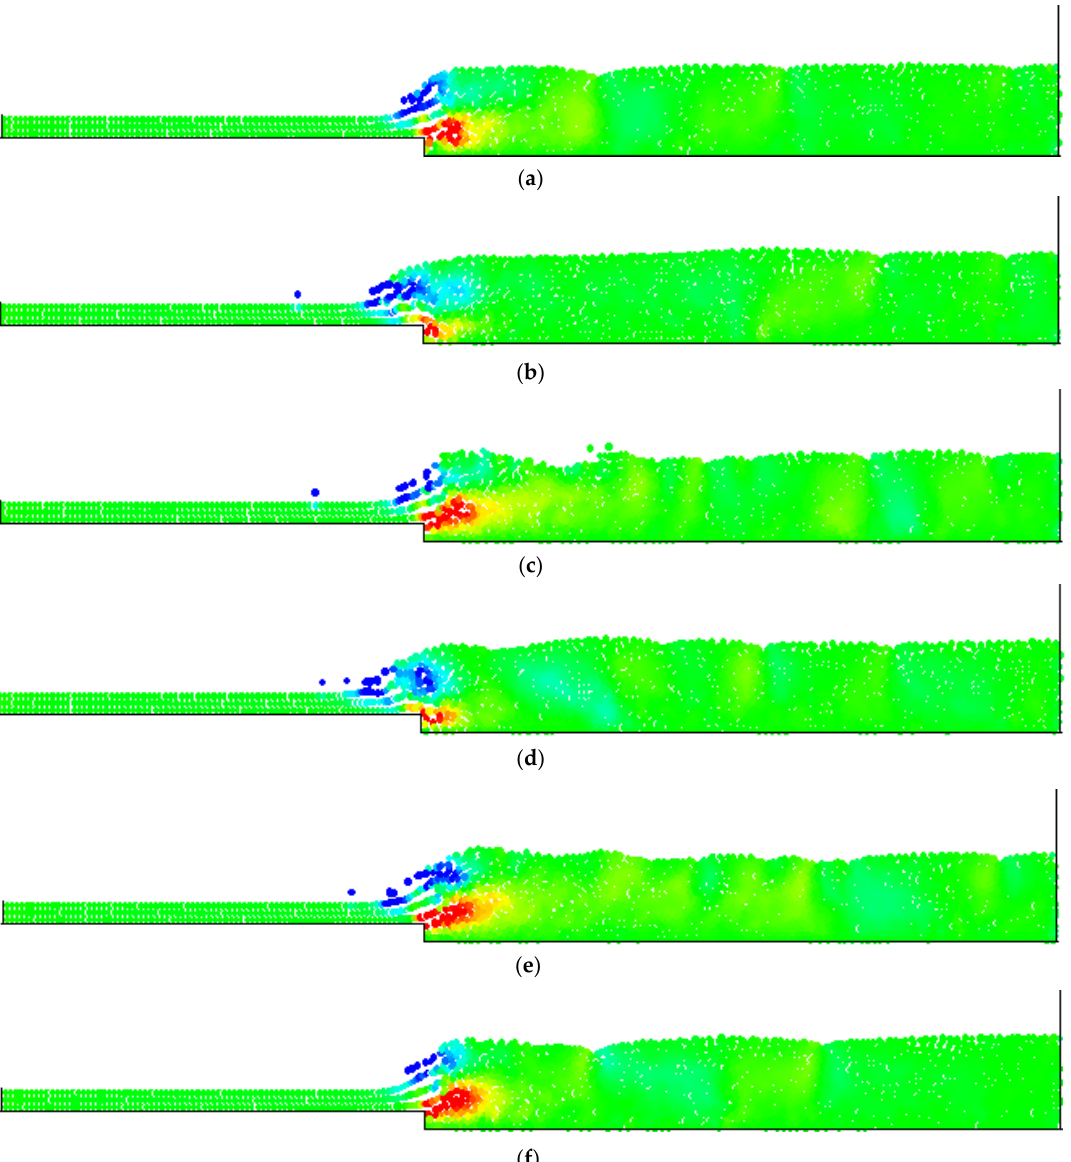
Figure 10. Instantaneous SPH vorticity field in the SPH simulation of Test T4: ( a ) t = 15 s; ( b ) t = 18 s; ( c ) t = 22 s; and ( d ) t = 24 s. Colour scale is the same as in Figure 7.